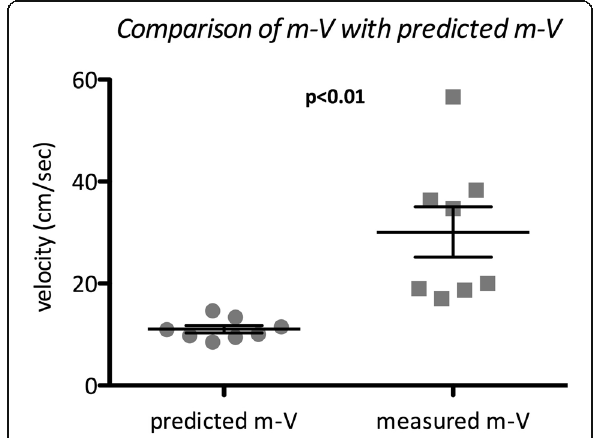
Fig. 1 Relationship between the measured mean velocities and the predicted values. The measured m-V was significantly faster than the predicted value in our study, both collectively ( p < 0.01) and in every patient